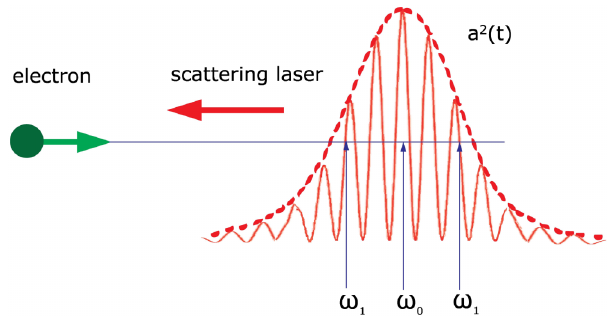
FIG. 5. Schematic diagram illustrating the time varying pon- deromotive potential experienced by an electron as it collides with a counterpropagating laser